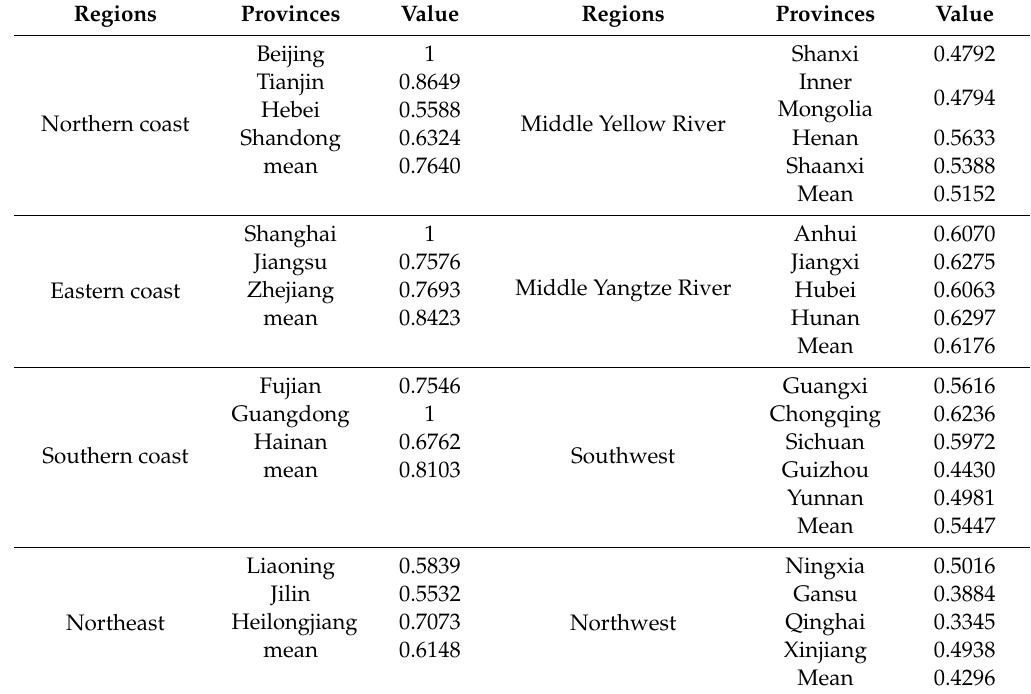
Table 4. Carbon emission e ffi ciency in the Chinese eight